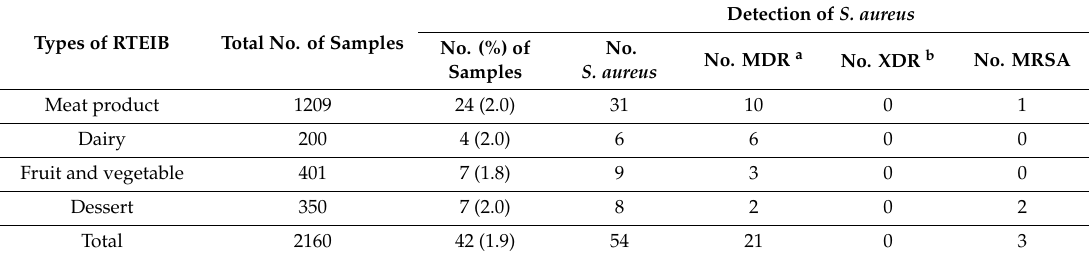
Table 3. The prevalence of Staphylococcus aureus —multidrug-resistant (MDR), extensively drug-resistant (XDR) and methicillin-resistant S. aureus (MRSA) types in 2160 RTEIB foods, including meat, dairy, fruit and vegetables, and